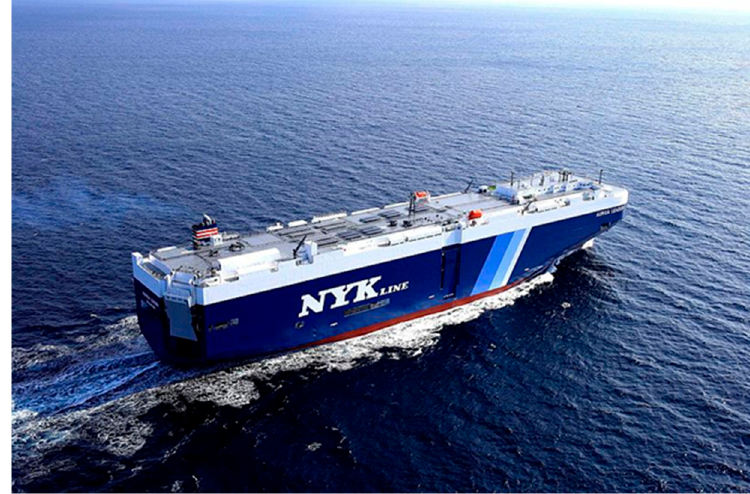
Figure 13. MV Auriga Leader with solar power array, NYK Lines (adapted from Goodwill-